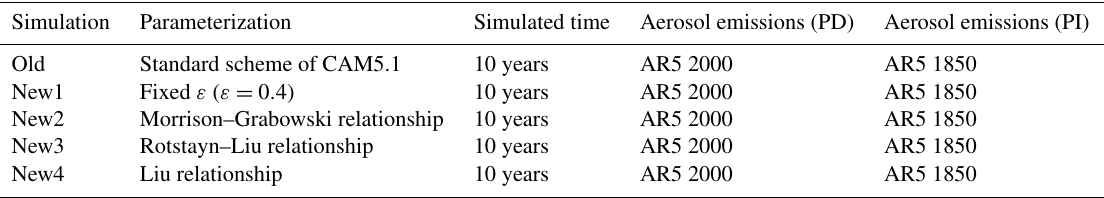
Table 1. Description of simulations performed in our study. Simulation Parameterization Simulated time Aerosol emissions (PD) Aerosol emissions (PI) Old Standard scheme of CAM5.1 New1 Fixed ε ( ε = 0 . 4) New2 Morrison–Grabowski relationship Liu